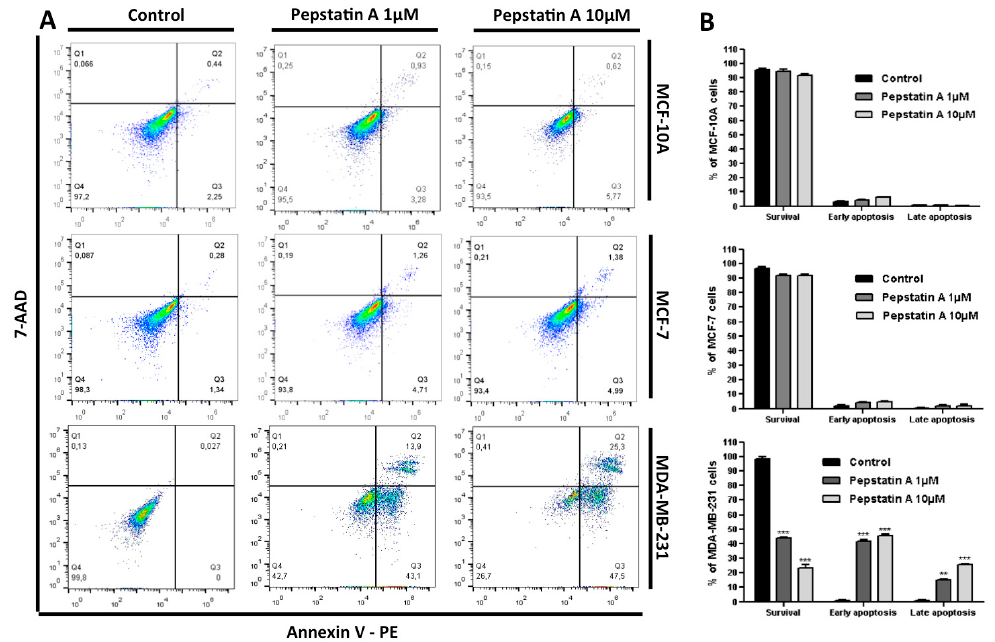
Figure 4. CatD inhibition induces apoptosis only in MDA-MB-231 cells. ( A ) The apoptotic fraction of MCF-10A, MCF-7, and MDA-MB-231 cells after 24 h treatment with PepA (1 μ M and 10 μ M) compared to control (vehicle only) is shown, with numerals in the lower right-hand panel (early apoptosis) and in the upper right-hand panel (late apoptosis). Annexin V and 7-AAD staining were used to assess the basal level of early (Annexin-V-labeled cells) and late apoptosis (Annexin-V- and 7-AAD-labeled cells). ( B ) PepA induced early and later apoptosis rate shown by histogram. Data are expressed as the mean ± SD of three independent experiments. Asterisks indicate significant difference from control group (**, p < 0.01; ***, p < 0.001). Comparisons between different groups were performed using one-way analysis of variance.